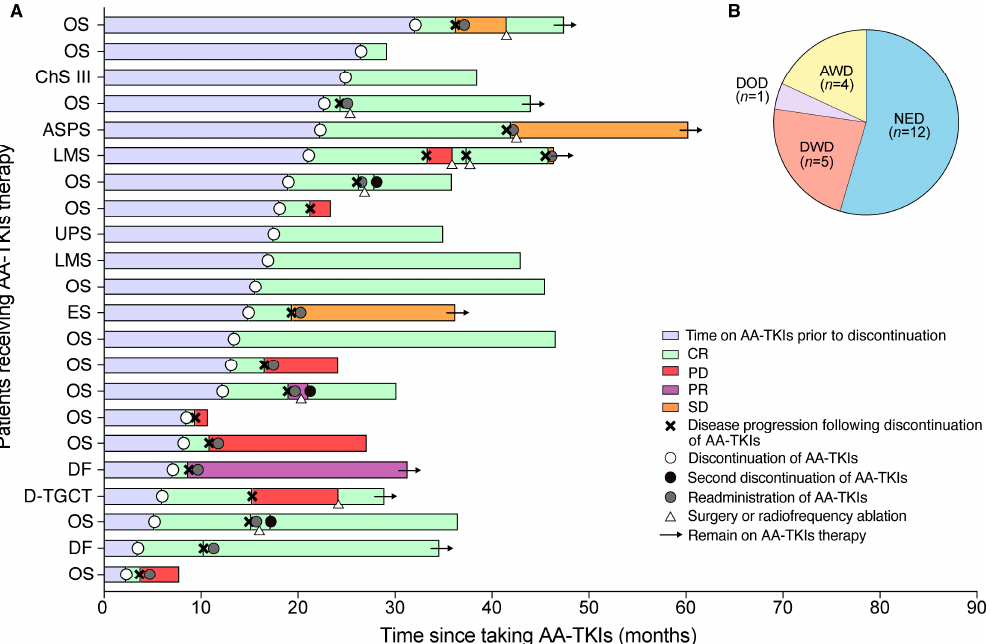
Figure 2. Clinical outcomes following discontinuation of TKIs. ( A ) Each bar represents one patient in this study ( n = 22) and sarcoma subtypes are shown on Y-axis labels. Black crosses are the time-point at which radiographic disease progression occurred that was used in the analysis. Twelve patients re-administered TKI therapy after discontinuation due to disease progression. Green bars show no radiographic confirmation of tumor lesions. ASPS = alveolar soft-part sarcoma. OS = osteosarcoma. ChS III = chondrosarcoma grade III. LMS = leiomyosarcomas. UPS = undifferentiated pleomorphic sarcoma. ES = Ewing sarcoma. DF = desmoid fibromatosis. D-TGCT = diffuse-type tenosynovial giant cell tumor. CR = complete response. PD = disease progression. PR = partial response. SD = stable disease. ( B ) Pie chart shows the 22 patients’ outcomes. NED = no evidence of disease; AWD = alive with disease; DWD = died with disease; DOD = died of other disease.